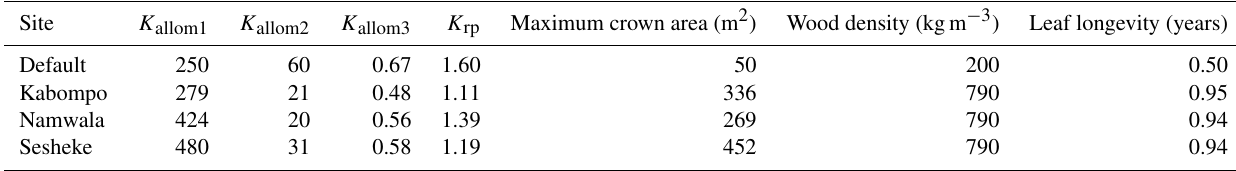
Figure 2. Projected changes in rainfall (a) , mean temperature (b) , incoming solar radiation (c) , number of wet days (d) , and CO 2 concen- tration (e) under RCP4.5 and RCP8.5 by the end of the 21st century. The end of the 21st century is the period 2070–2099. Values were determined as means of the five GCMs and changes were determined with reference to the 1960–1989 period as the baseline. For sources of data, refer to Sect. 2.4. Table 2. Local and default tree parameter values used in LPJ-GUESS. K rp , K allom1 , K allom2 , and K allom3 are constants in allometric equations (see Sect. 2 and Smith et al., 2001). Default parameters were provided together with the model code (Smith et al.,